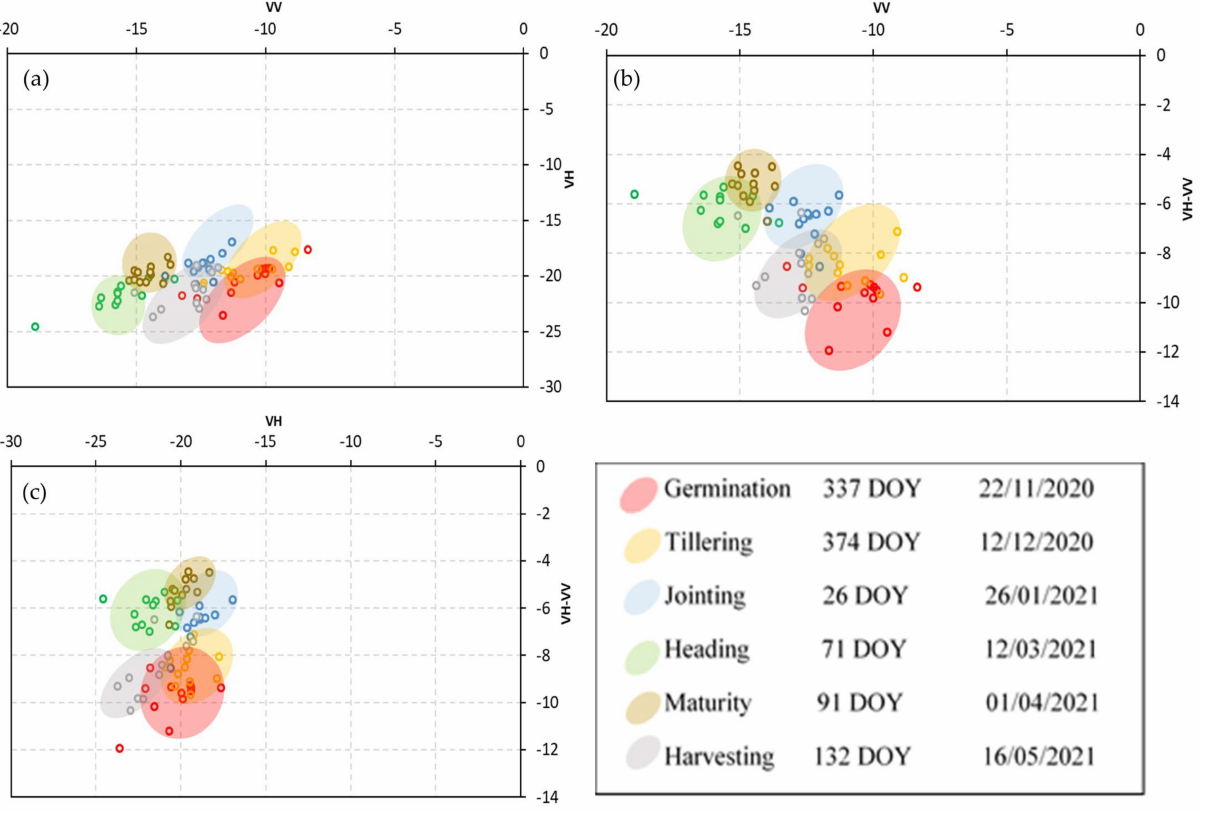
Figure 9. The scatterplot of the field samples of the wheat plots under consideration in a space including the VV and VH ( a ), VV and VH–VV ( b ), VH and VH–VV ( c ) for the different dates of wheat